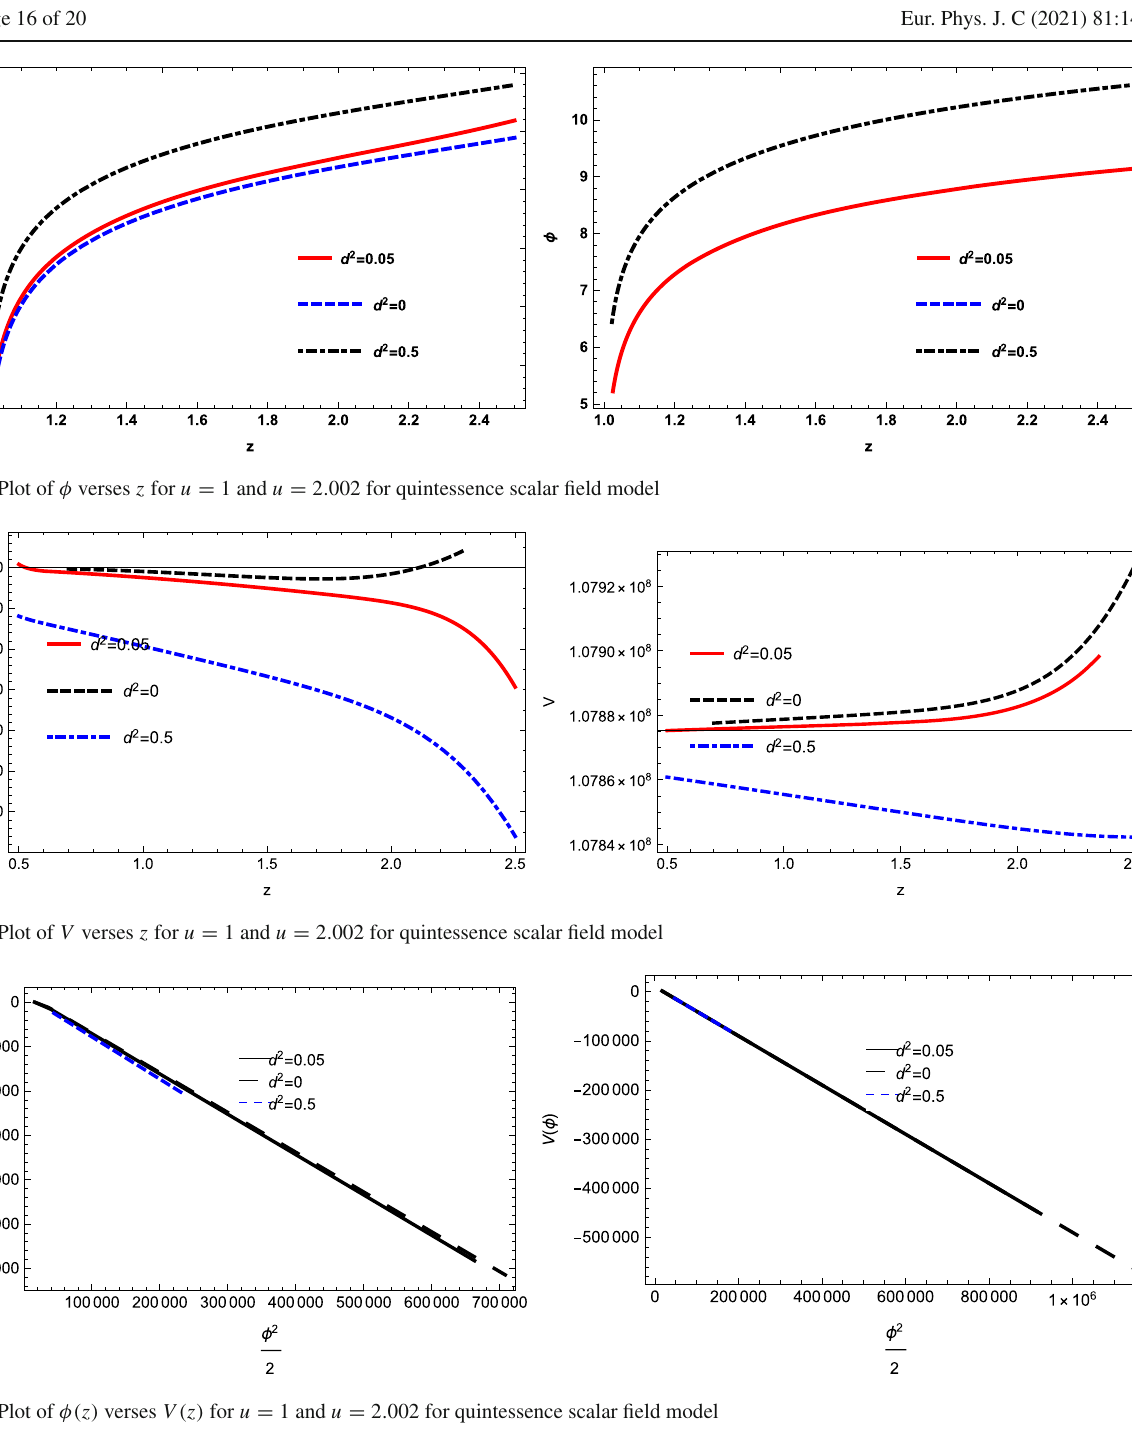
Bianchi type III